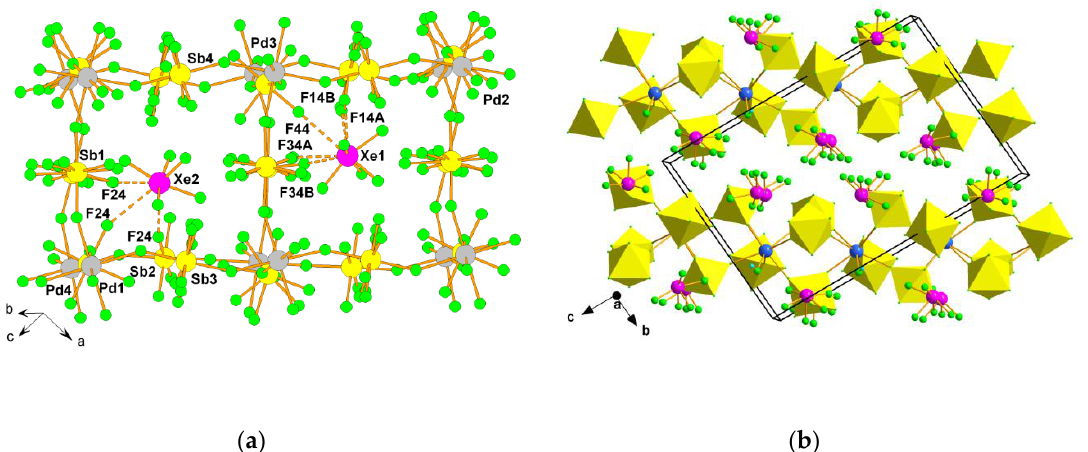
Figure 14. ( a ) Part of the crystal structure of β -XeF 5 Pd(SbF 6 ) 3 (296 K). Disorder of [XeF 5 ] + cations is not depicted. Only F atoms involved in secondary Xe ··· F contacts are labeled; ( b ) Packing of the columns in the crystal structure of (XeF 5 ) 3 [Hg(HF)] 2 (SbF 6 ) 7 with a triclinic unit cell. Copyright (2016) Wiley. Used with permission from Ref. [40].